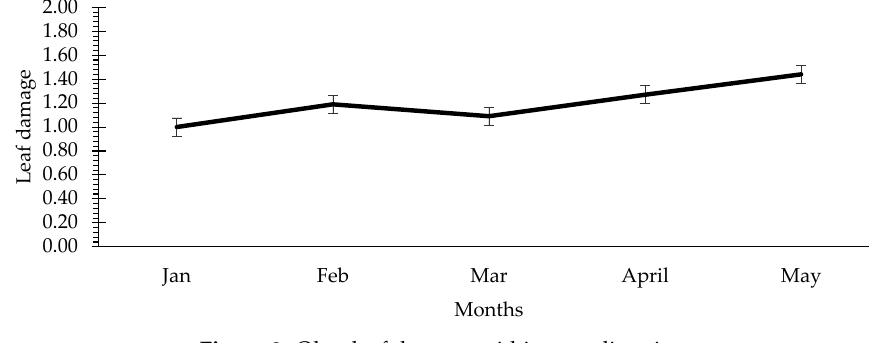
Figure 2. Okra leaf damage within sampling time.